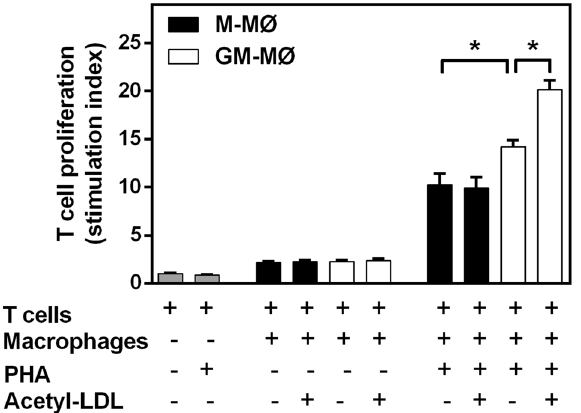
Figure 7. Effect of lipid-loading on the capability of M-MØ and GM-MØ to support T cell proliferation. For each experiment, M-MØ and GM-MØ were prepared from a buffy coat derived from a single human donor. The macrophages were incubated in the absence or presence of acetyl-LDL (25 µg/mL) for 24 h in serum-free DMEM, after which the cells were washed, autologous T cells were added and co-cultured in the presence or absence of 10 µg/mL phytohemagglutinin (PHA). As a control, the T cellswere cultured alone (grey bars). After 4 days, the T cell numbers in the medium were counted. T cell proliferation was expressed as a stimulation index defined as a ratio obtained by dividing the number of viable T cells in the presence of macrophages by the number of viable T cells in the absence of macrophages. Data (means ± SEM) are derived from triplicate wells and correspond to 3 monocyte donors. *p < 0.05 by Wilcoxon Signed-Rank test for paired